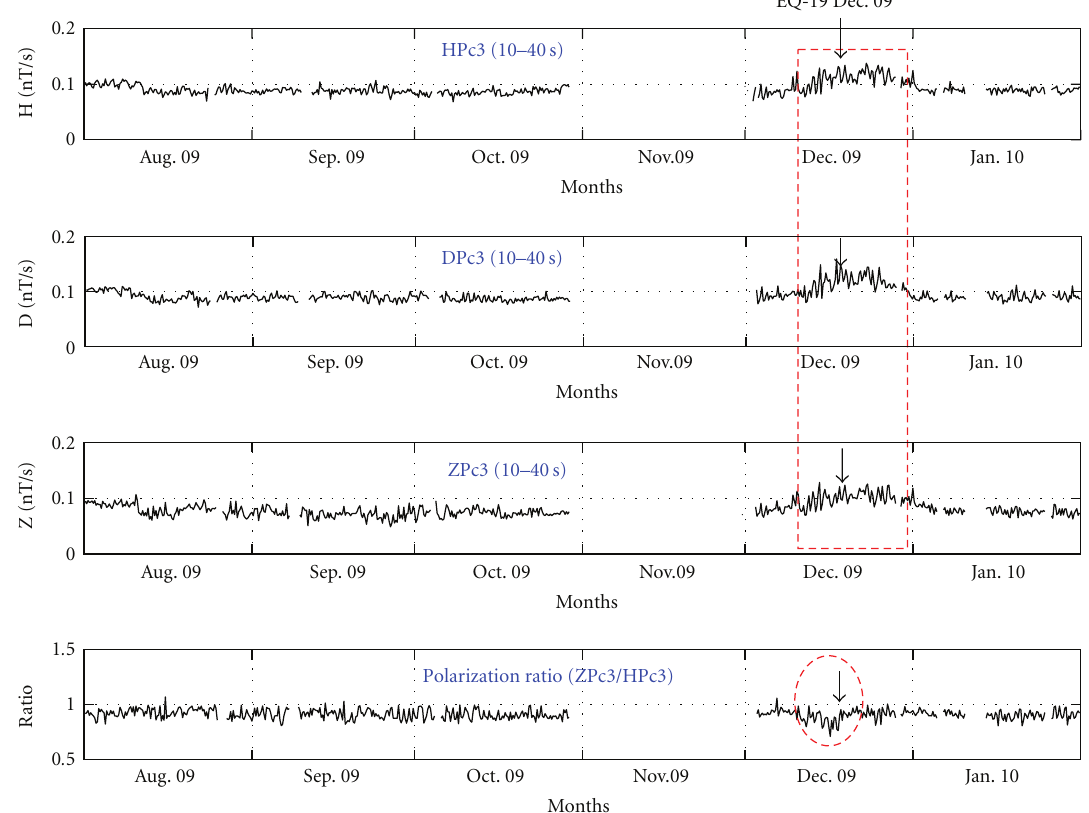
Figure 7: Six-hours average values of the Pc 3 amplitude of the geomagnetic components (H, D, and Z) at the HLN station between August 2009 and January 2010 (band-pass filter (10–40 s)) and the Polarization ratio Z/H of Pc 3 (10–40 s) amplitude observed at the HLN station during the same period (the lower